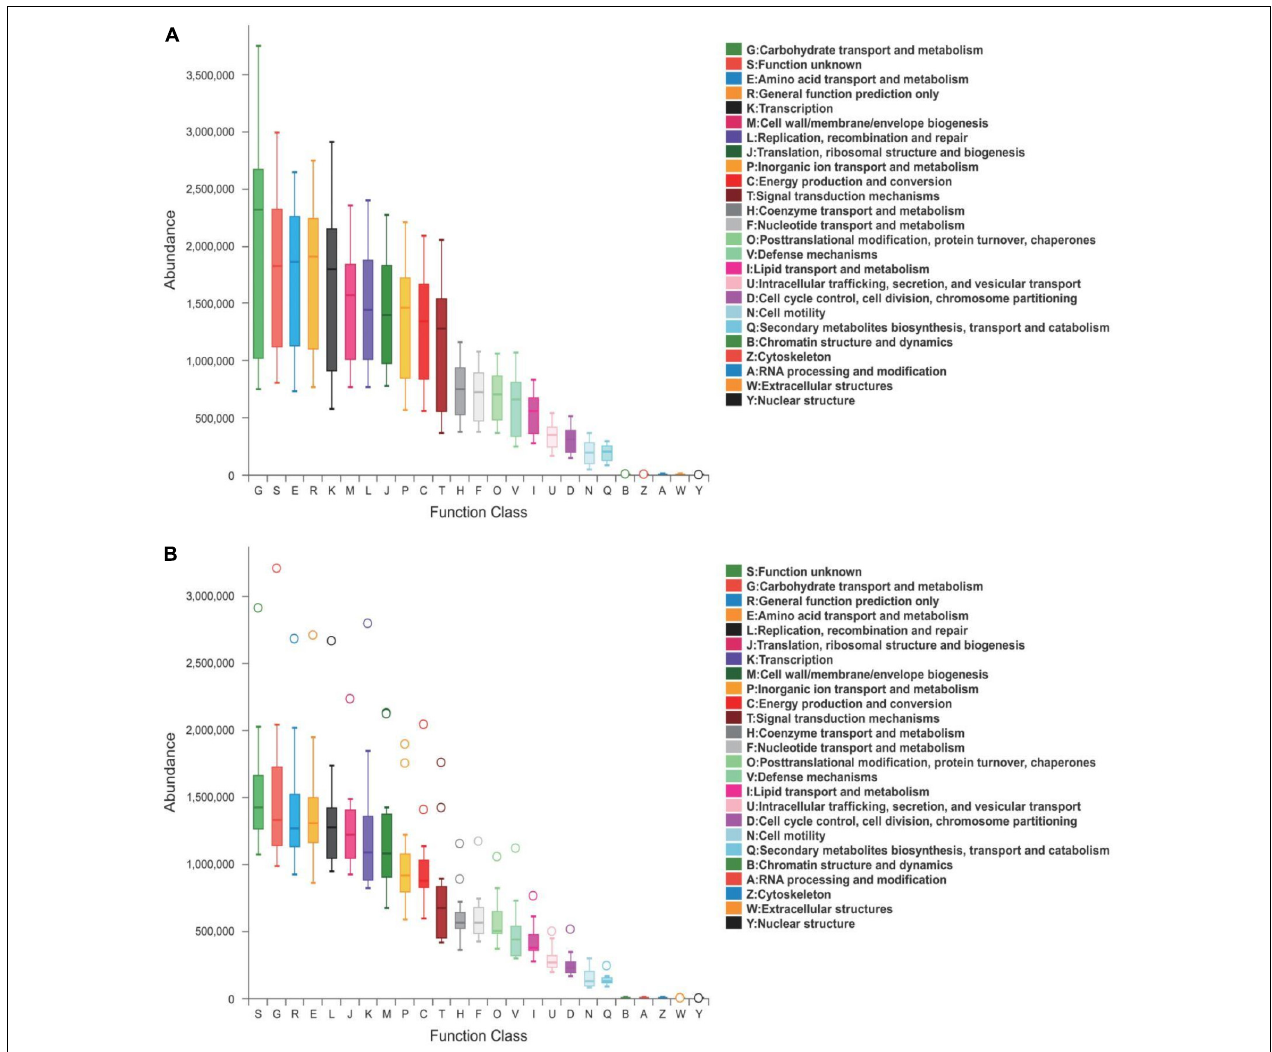
FIGURE 5 | COG functional classification in (A) healthy and (B) diarrhea piglets. Boxes represent the interquartile range (IQR) between the first and third quartiles. The lines and spots inside the boxes represent the median and mean, respectively. Whiskers denote the lowest and highest values within 1.5 × IQR from the first and third quartiles, respectively. The ring above the box indicates the